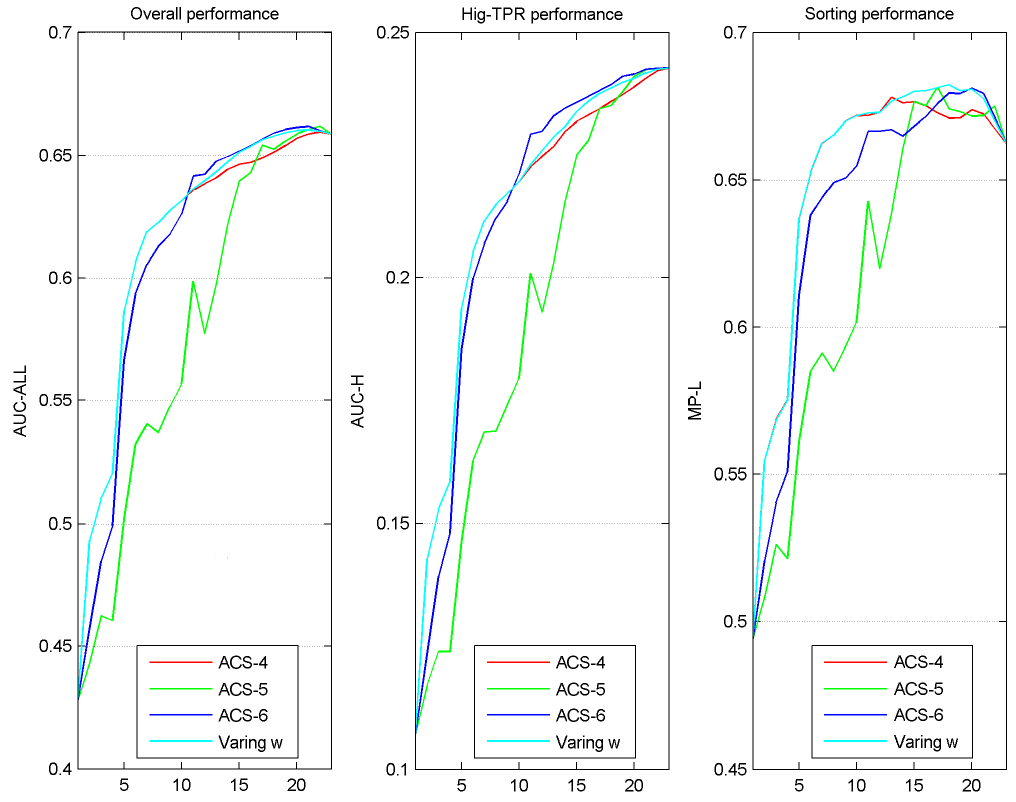
Figure 9. Performance-evolution graph of the ACS method with varying parameter w, coupled with SVM.